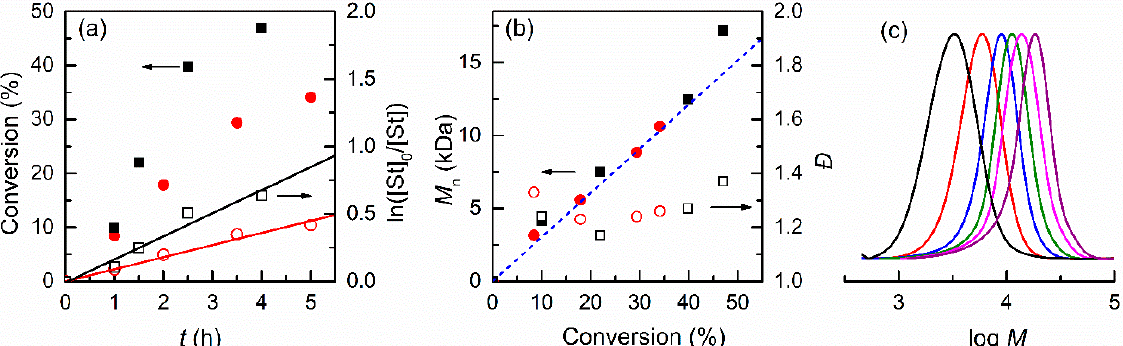
Figure 3. ( a ) First-order kinetic plots and ( b ) evolution of M n and Ð with conversion for potentiostatic e ATRP of styrene in DMF (circles) or CH 3 CN (squares), performed at 80 ◦ C at E app = E 1/2 with [St]:[EBiB]:[Catalyst] = 435:1.5:0.1; DP = 291; [Cu II ] = 1 mM. The dashed line in ( b ) represents theoretical molecular weights. ( c ) Molecular weight distributions of PS-Br produced by e ATRP of 50% ( v / v ) styrene in DMF.